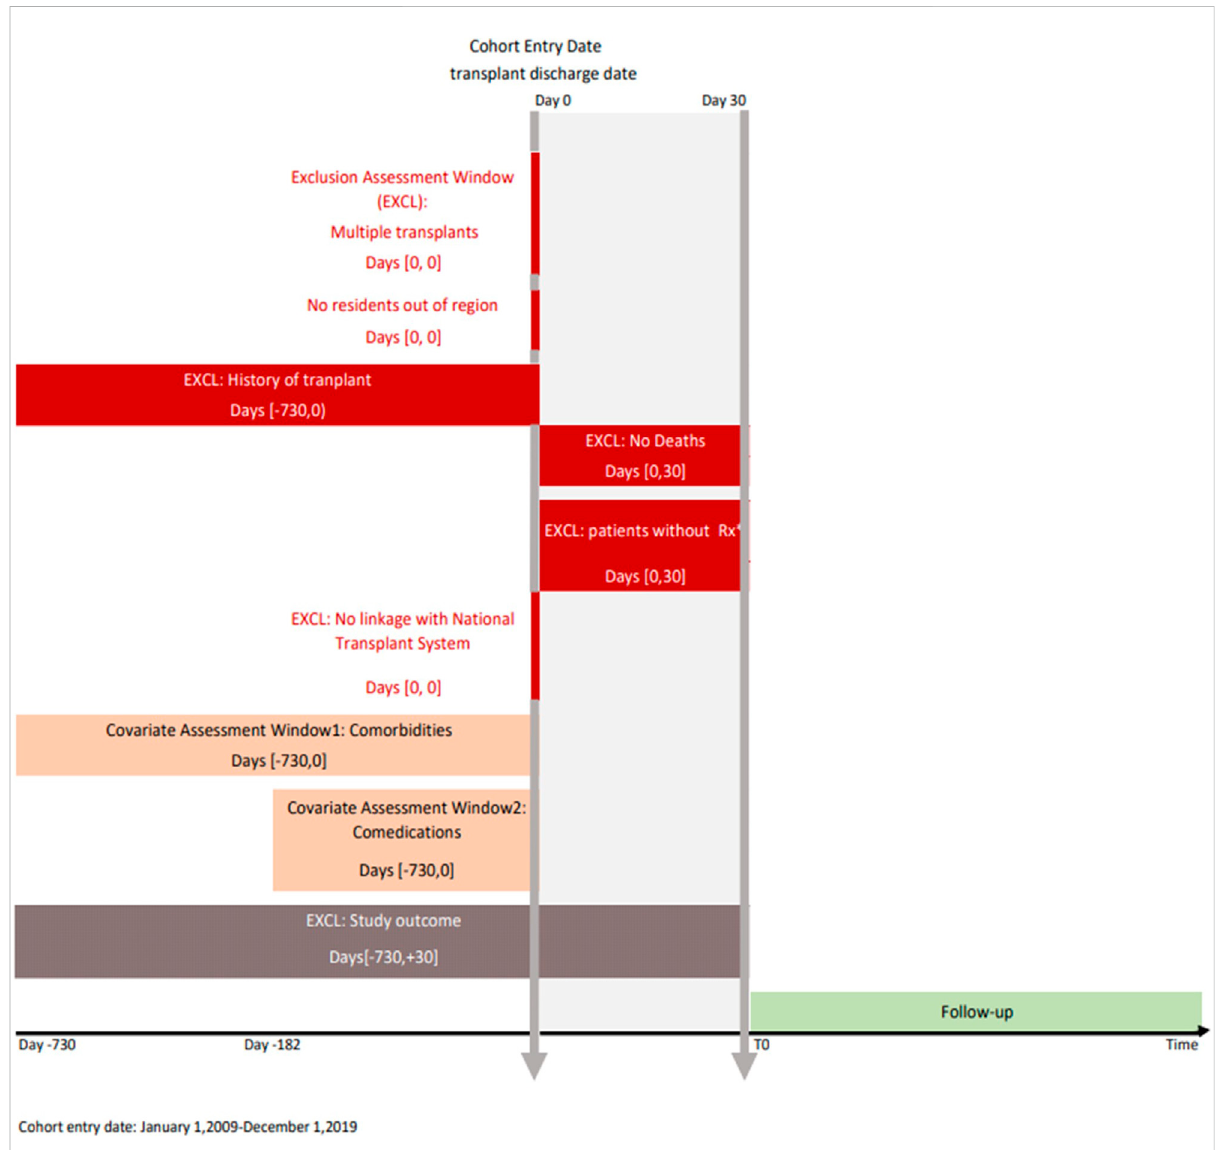
FIGURE 3 Studydesigndiagram.Note:Thestudydesigndiagramvisuallydisplaysstudydesignimplementation.The fi rstverticallinerepresentsthecohort entry date (index date) and the second represents the landmark period (30 days). The boxes represent time windows used to perform exclusion or covariate assessment. The brackets in the boxes show time intervals anchored on day 0. Rx, immunosuppressive prescription; EXCL,